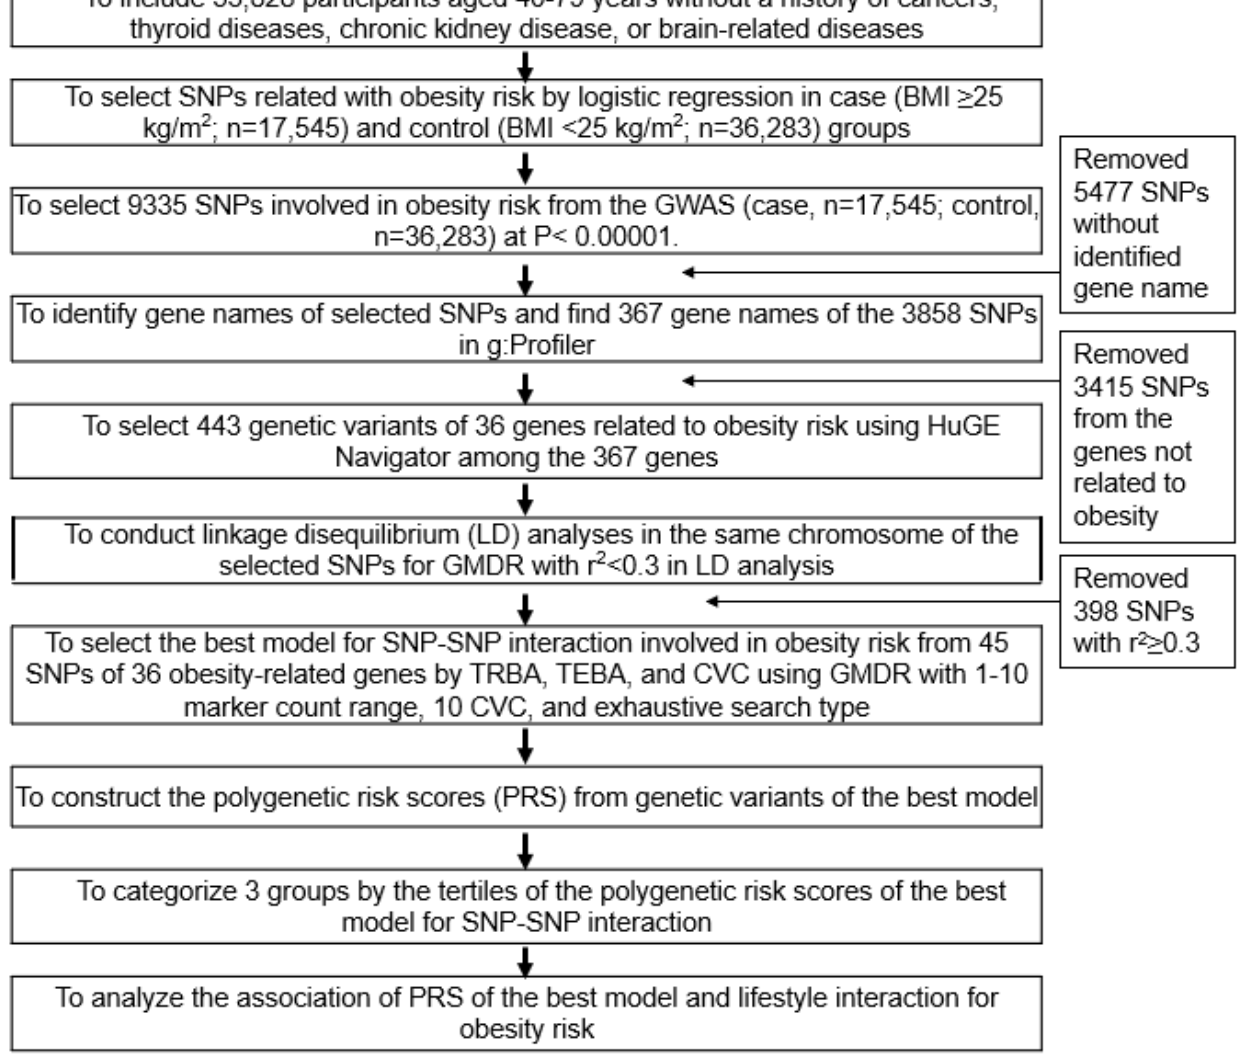
Figure 1. Flow chart for the generation of polygenetic variants that increase the risk of obesity and interactions between polygenetic risk scores (PRS) and lifestyles.